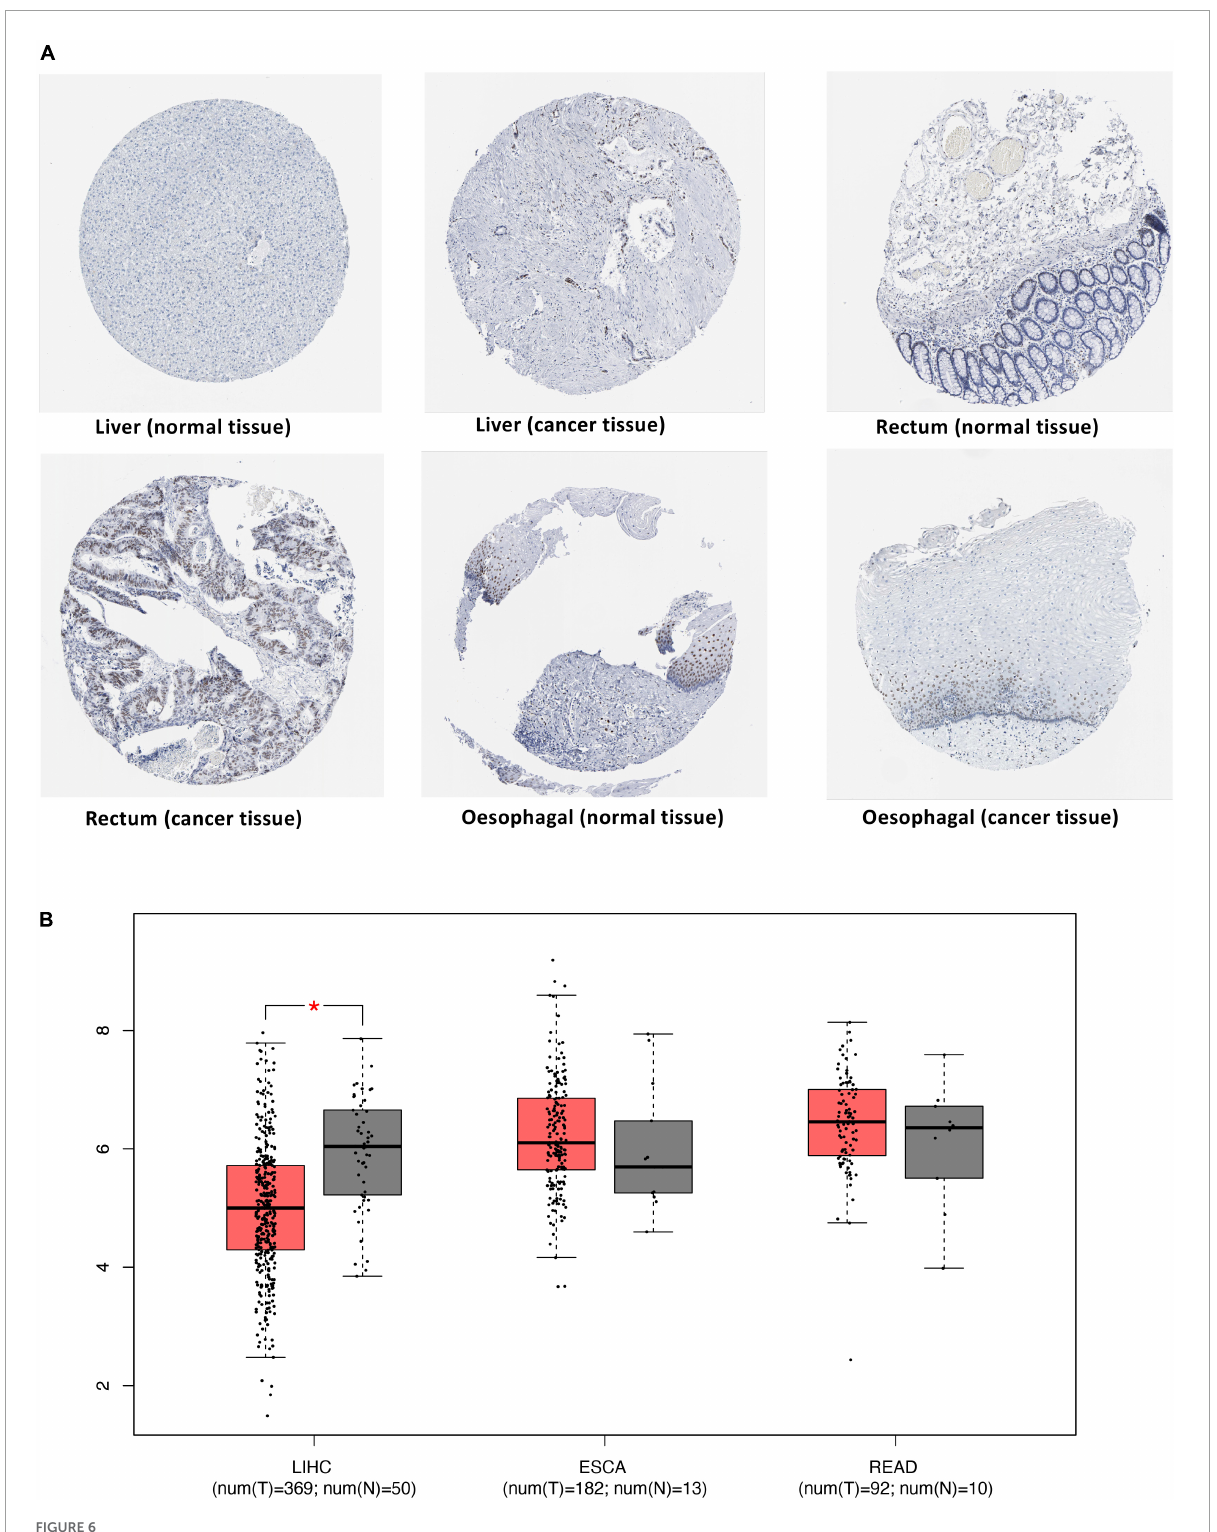
FIGURE6 Differential expression of JUN in cancers. (A) Validation of the expression of JUN at the protein level using the HPA database. (B) Validation of the expression of JUN at the transcriptome level using the TCGA database.